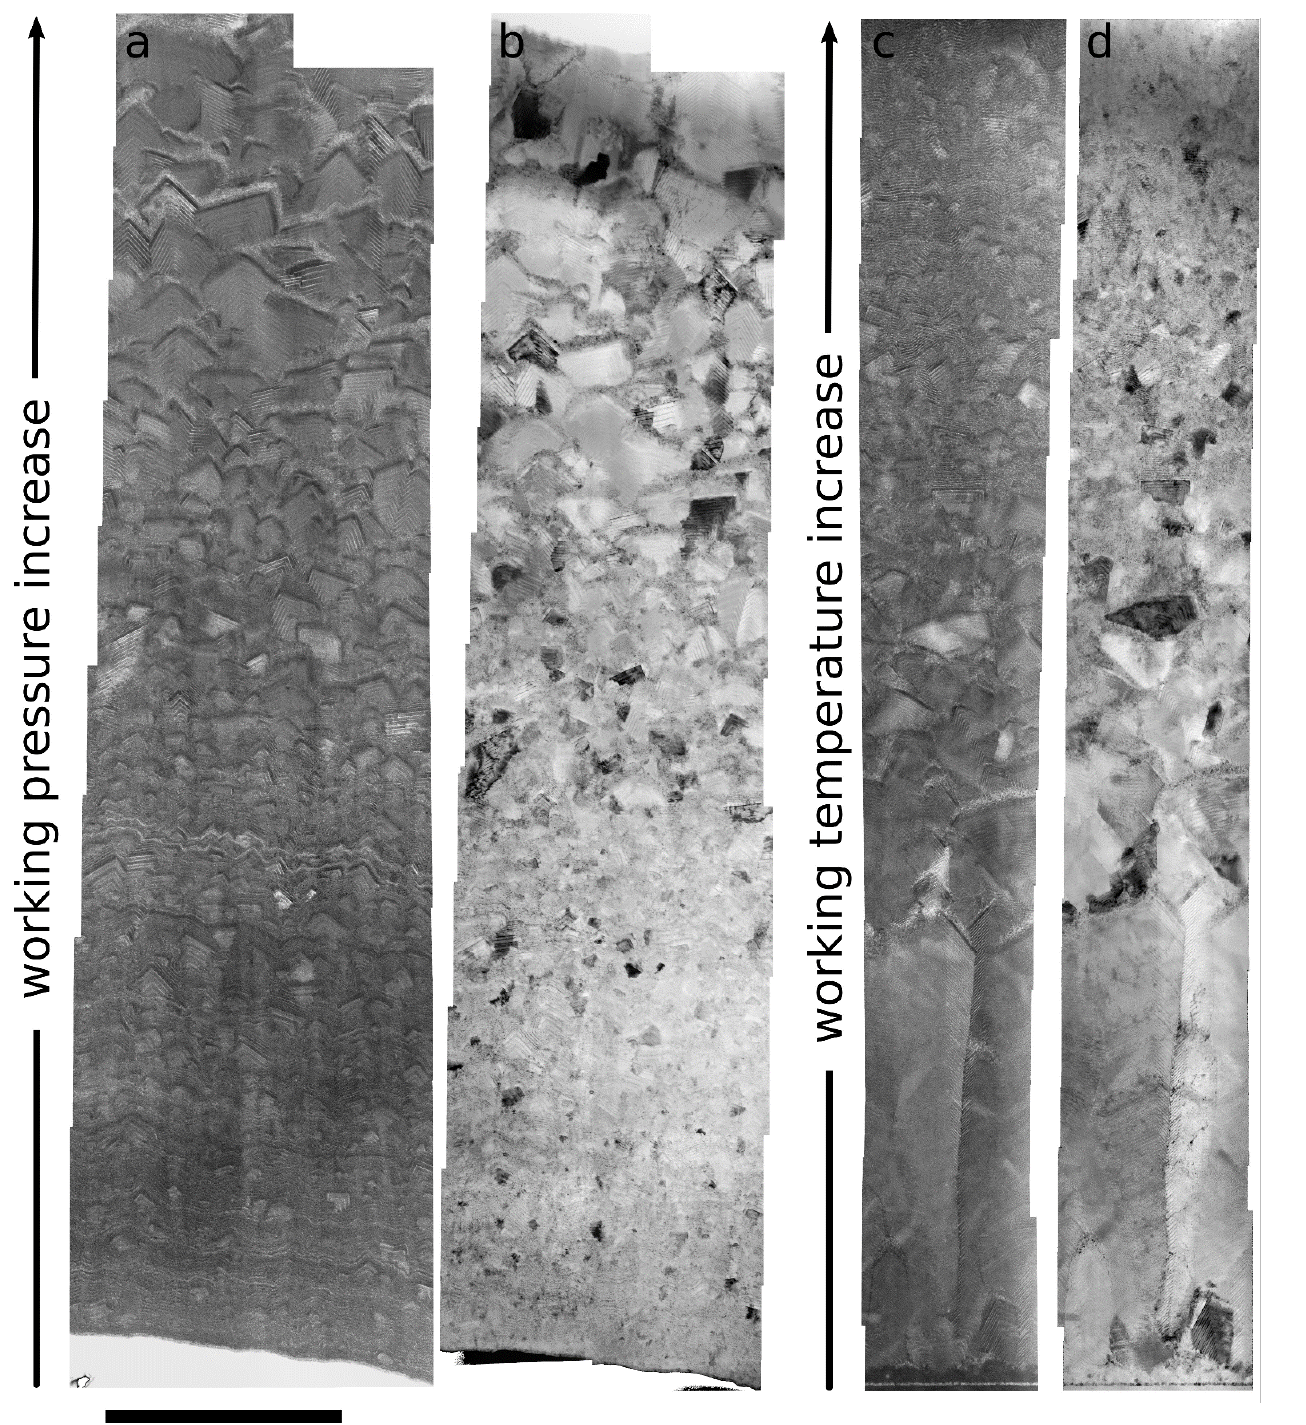
Figure 2. Cross-sectional microstructure of the p- ( a , b ) and T-coatings ( c , d ) obtained using high-angle annular dark-field (HAADF) scanning TEM (STEM) ( a , c ) and bright-field STEM ( b , d ). The scale bar corresponds to 1 µm.